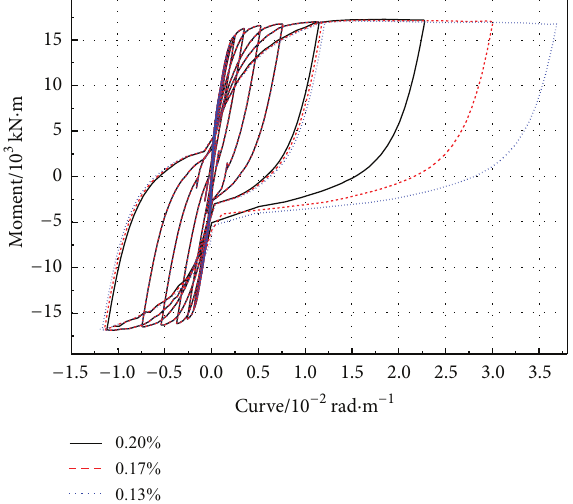
Figure 9: Key points on the skeleton curve of the bottom section of PRC pier with different longitudinal reinforcement ratios.